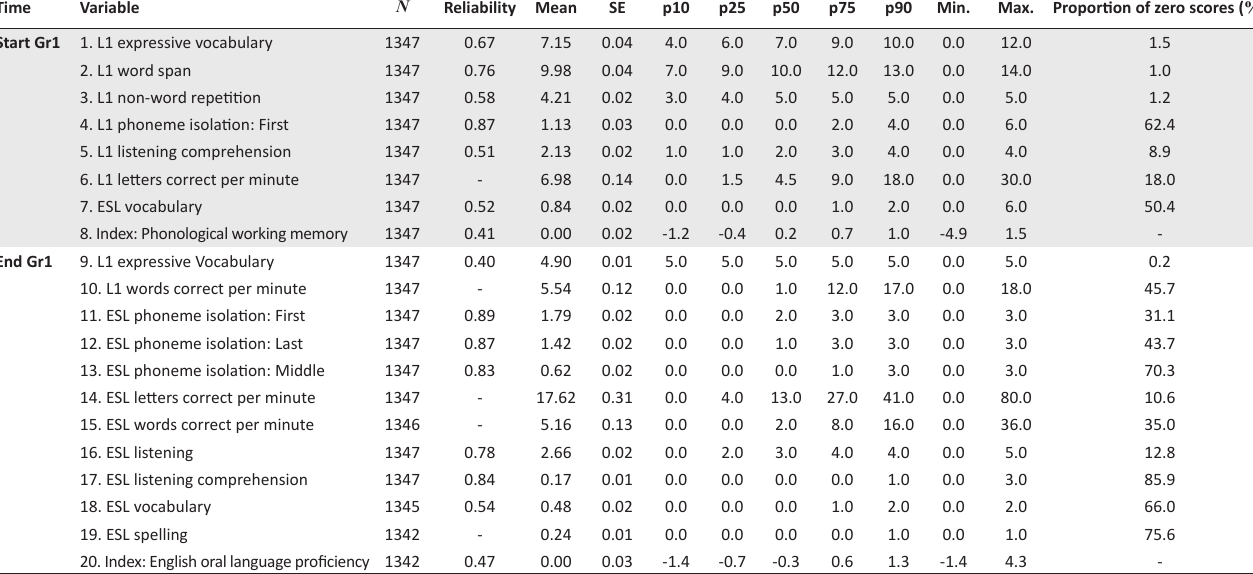
TABLE 3: Sub-test descriptive statistics.